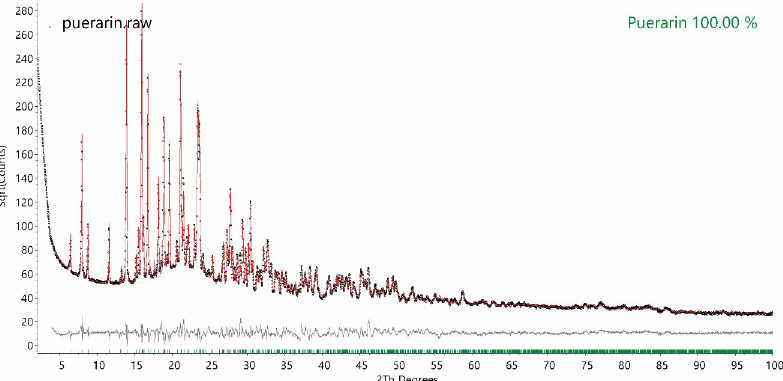
Fig 7. Rietveld refinement of the puerarin crystal structure using rigid body model to simulate (red line) the measured XRD pattern (black dot) of the pure puerarin sample. Rwp = 7.36%, χ 2 =